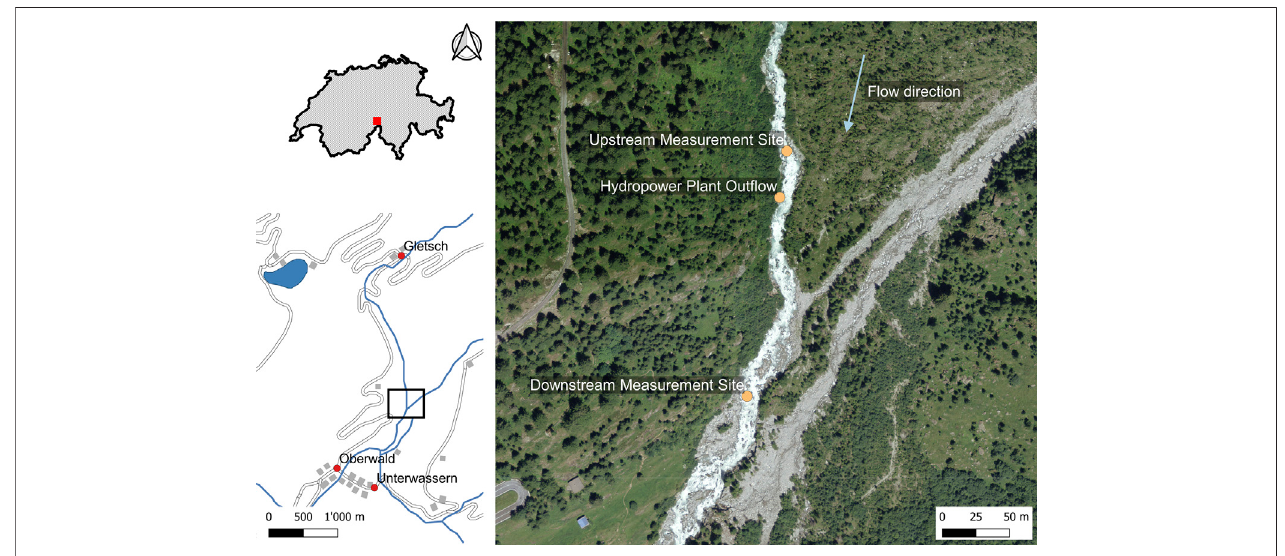
FIGURE 1 | Location of the Gletsch – Oberwald SHP and the two measurement sites for the fi eld experiment. Incoming tributaries between measurement sites are intermittent (map generated using data from GeoVITe, 2019); data source: Federal Of fi ce of Topography.